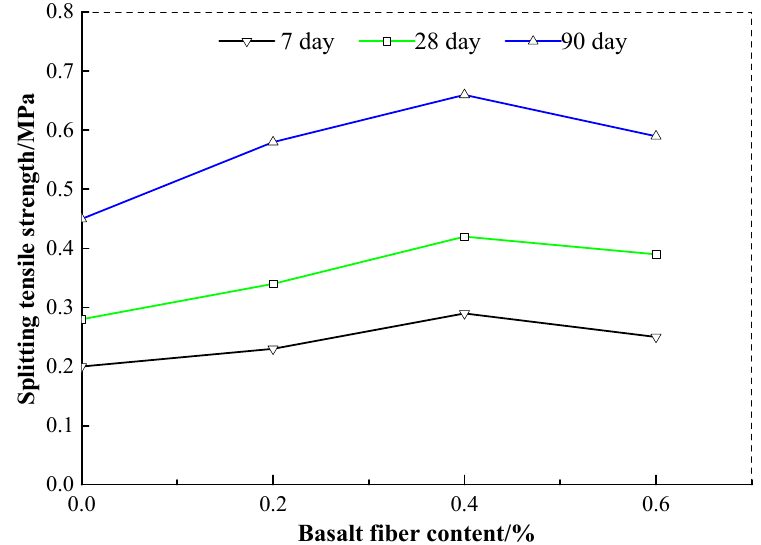
Figure 7. The relations between basalt fiber content and splitting tensile strength.